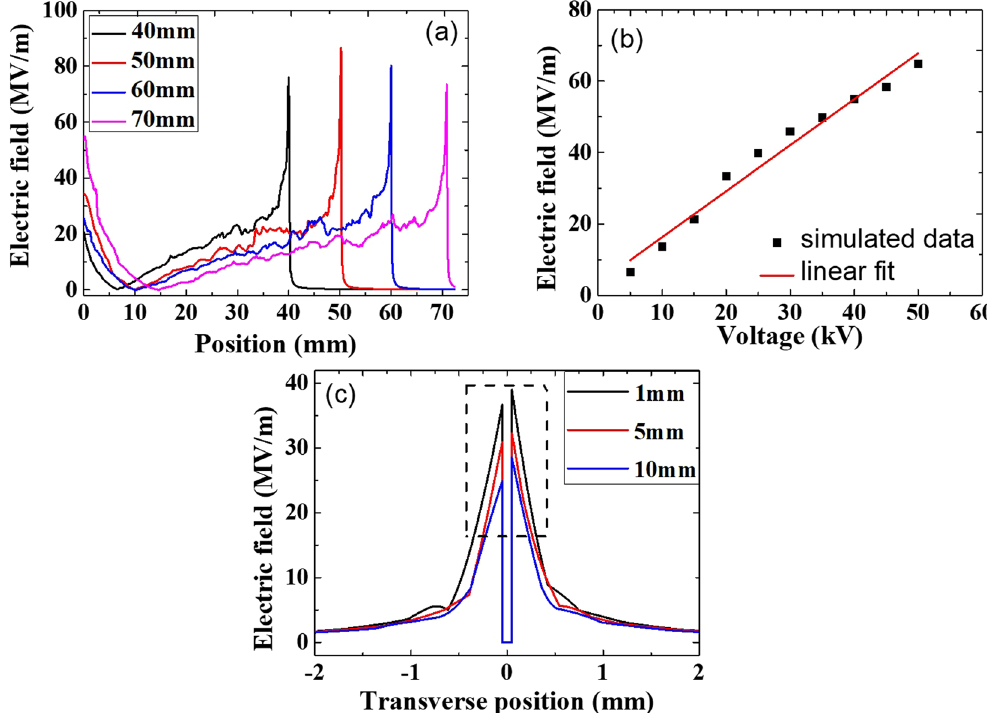
Figure 7. simulated electric field around the laser plasma channel end: ( a ) electric field distribution around the laser plasma channel end under different filament lengths of 40 mm, 50 mm, 60 mm, and 70 mm. The applied voltage was 50 kV; ( b ) the peak electric field around the end of 60 mm long plasma channel as a function of applied voltage. ( c ) the electric field distribution in the direction perpendicular to the laser propagation direction at three positions of 1 mm, 5 mm and 10 mm before the filament ends. The laser plasma channel position is defined as 0 and the negative transverse position is the side where the electrode was connected to the power supply (See Figs 1 and